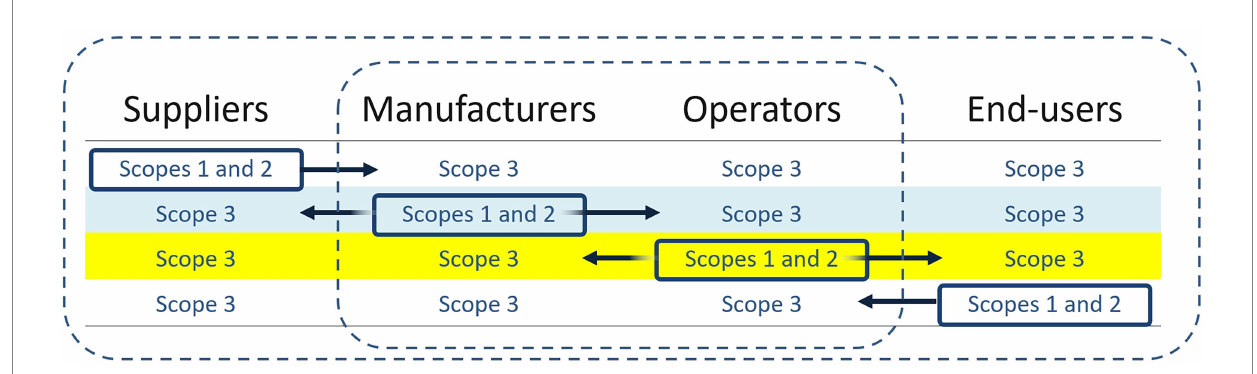
FIGURE 2 Accounting for the Scopes 1 and 2 of GHG emissions from the perspectives of suppliers, manufacturers, operators and end-users, and for the Scope 3 of other subjects in the supply chain. Adapted from Figure 1 of the ITU standard (ITU-T,